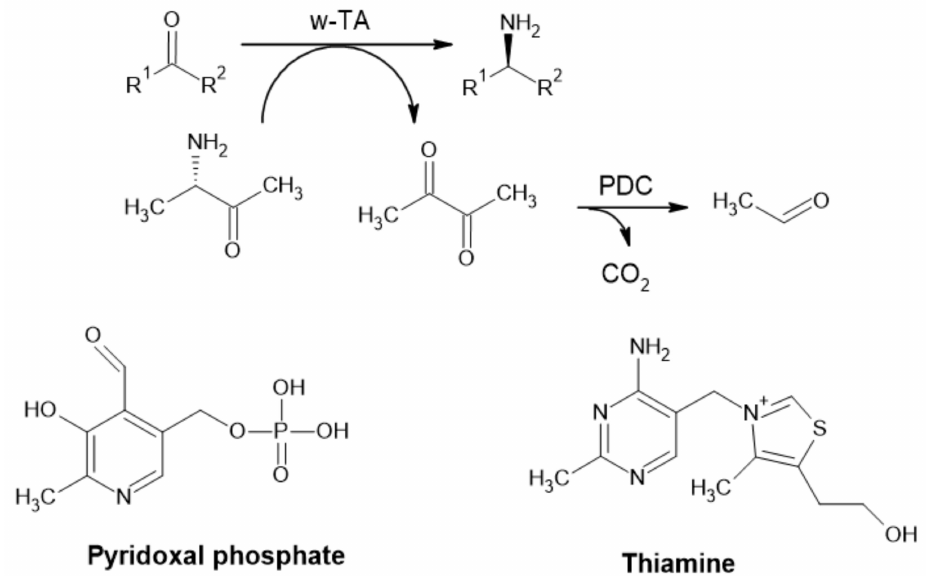
Figure 9. Synthesis of an α -chiral primary amine from ketone, employing ω -transaminase ( ω -TA) and removal of pyruvate by pyruvate decarboxylase (PDC) (Adapted with permission from ref. [4]. Copyright 2011 Wiley) and cofactors of ω